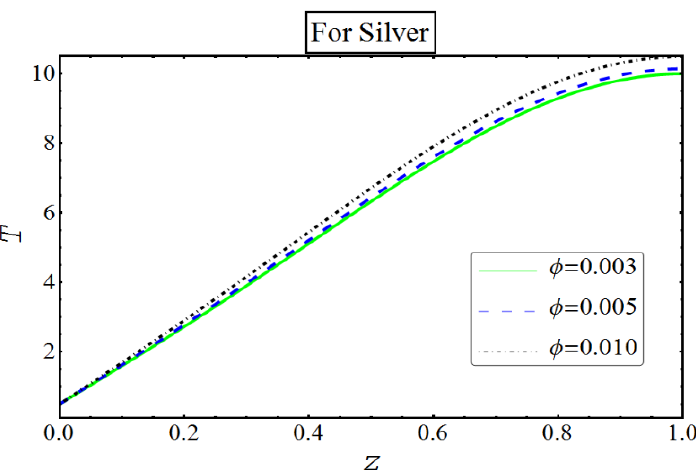
Figure 23. Temperature effects of concentration particles.